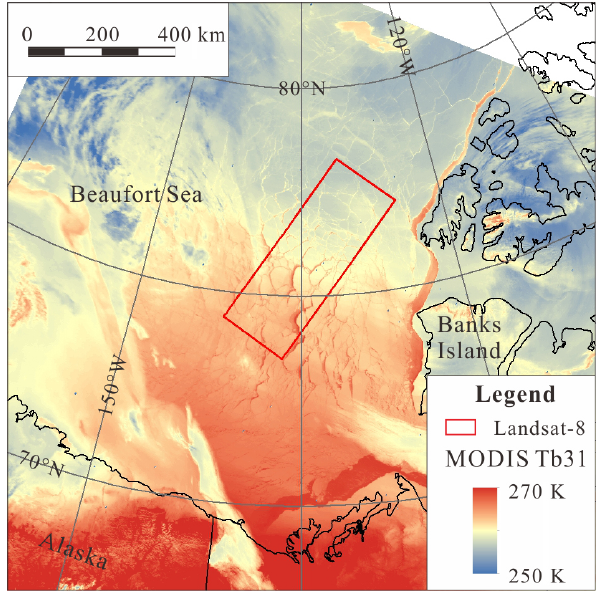
Figure 1. Location of study area. Background image is brightness temperature from Moderate Resolution Imaging Spectroradiome- ter (MODIS) band 31 ( ∼ 11µm). Location of Landsat-8 images is marked by a red